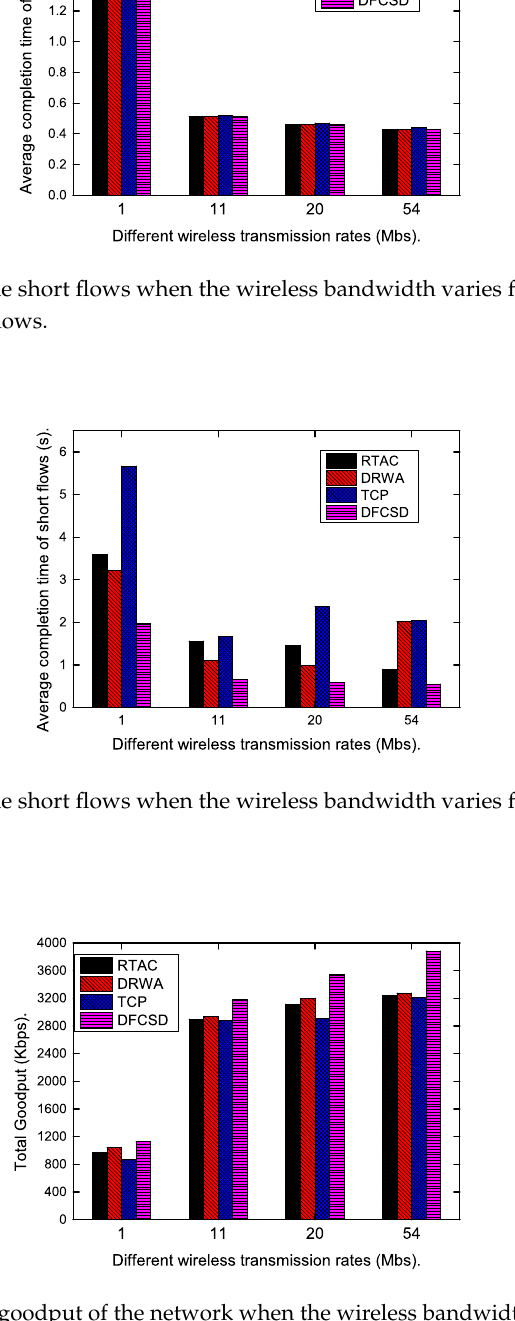
Figure 17. The obtained goodput of the network when the wireless bandwidth varies from 1 Mbps to 54